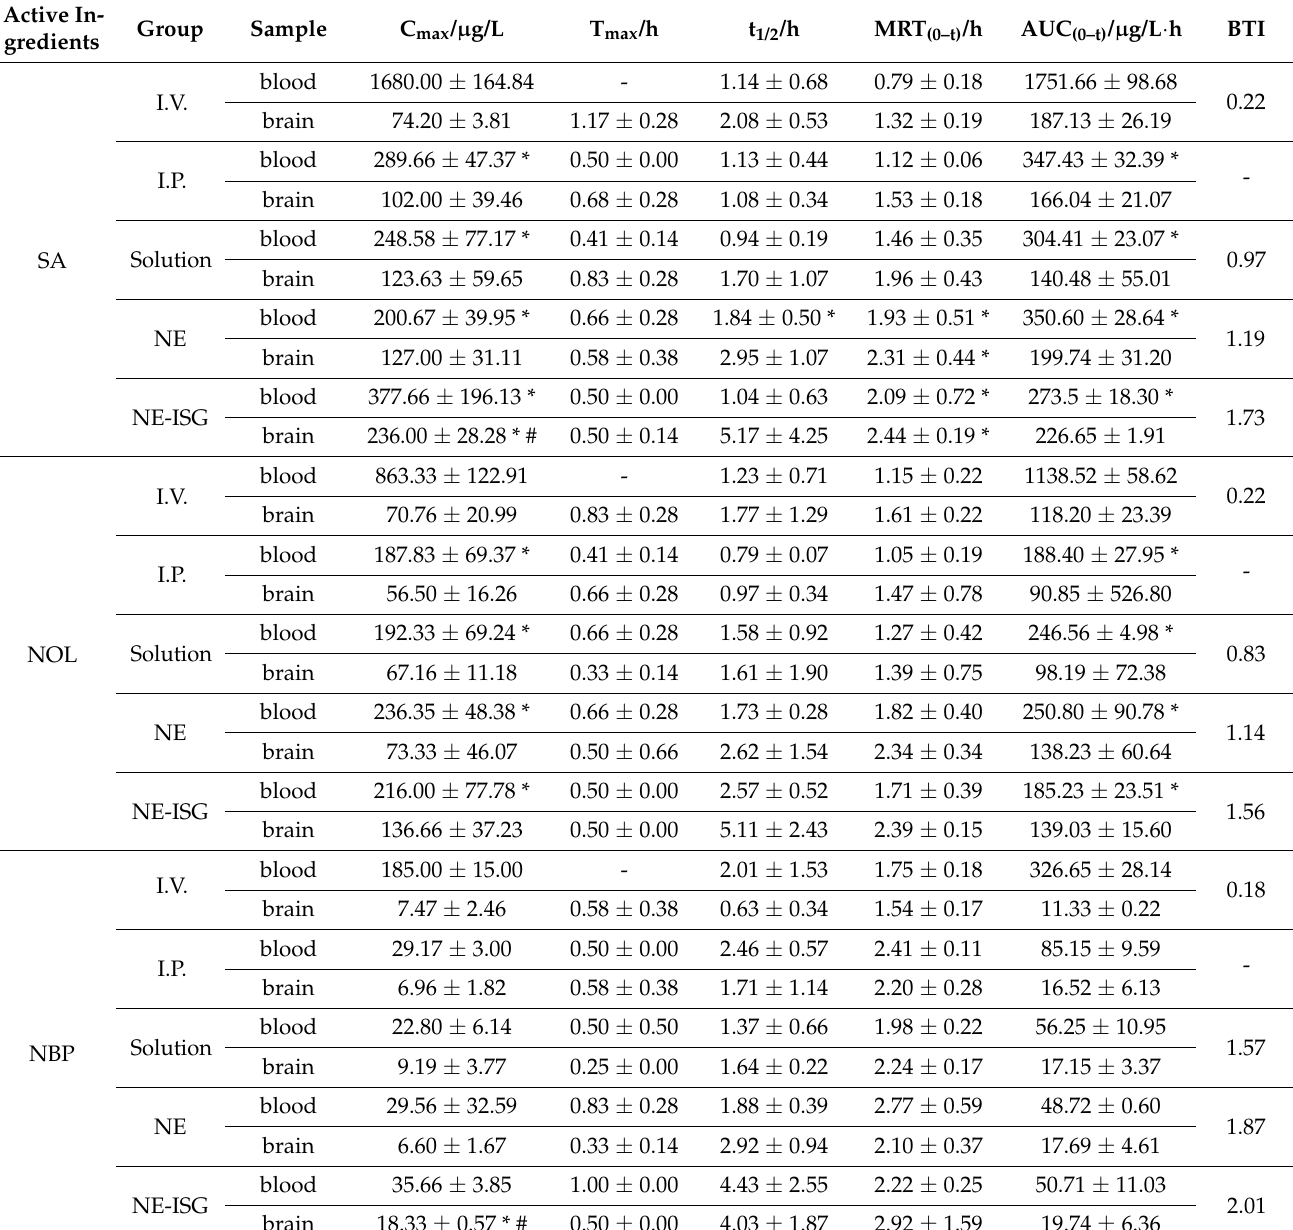
Table 3. Table of pharmacokinetic parameters of plasma and brain tissue of each index component in each group ( n = 3, X ±